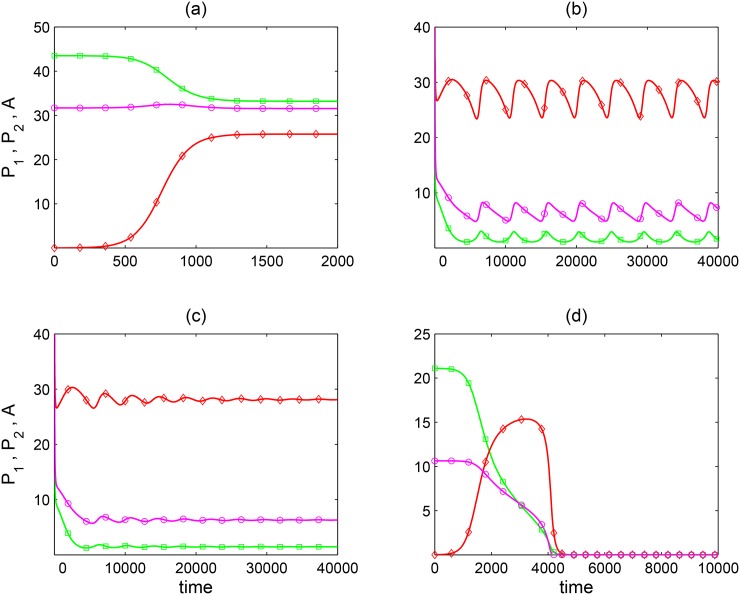

Model (1a) dynamics with fixed pollinator preferences.Population densities are represented by: green squares = plant 1, red diamonds = plant 2 and pink circles = pollinator. Panels (a) Ki = 60, u1 = 0.8, ci = 0.4, (b) Ki = 60, ci = 1.2, u1 = 0.605, (c) Ki = 60, ci = 1.2, u1 = 0.607 and (d) Ki = 35, u1 = 0.4, ci = 0.8 correspond to positions of points ⓐ, ⓑ, ⓒ and ⓓ in Fig 2. Other parameters as in Table 1.